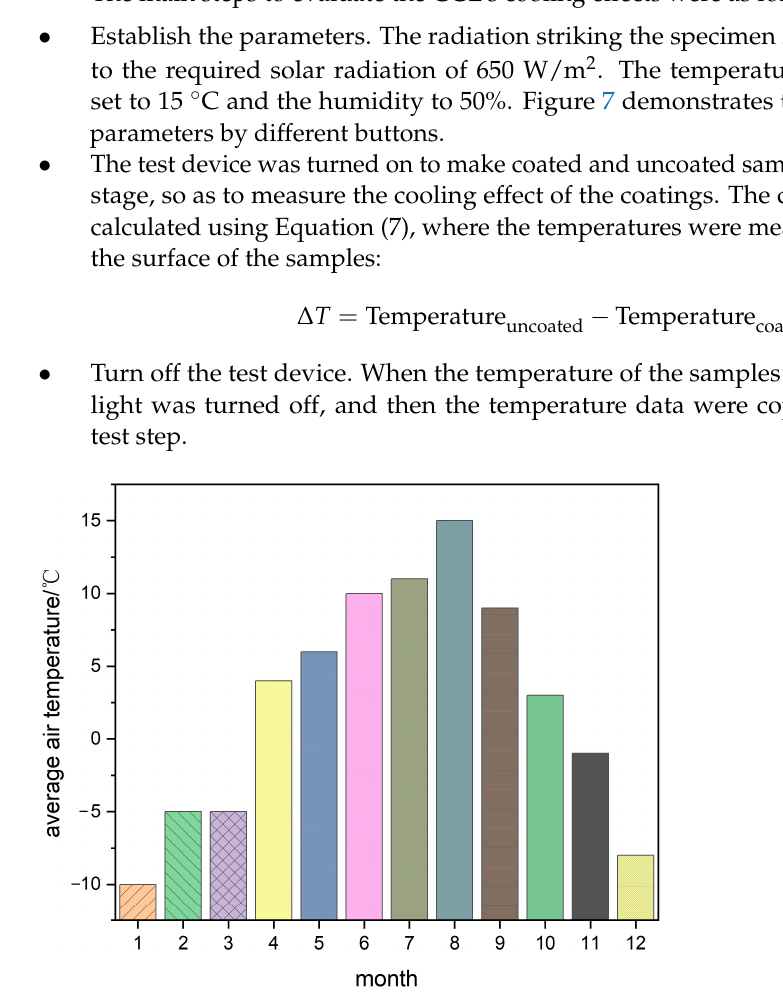
Figure 5. Average air temperature (°C) in every month of 2019.